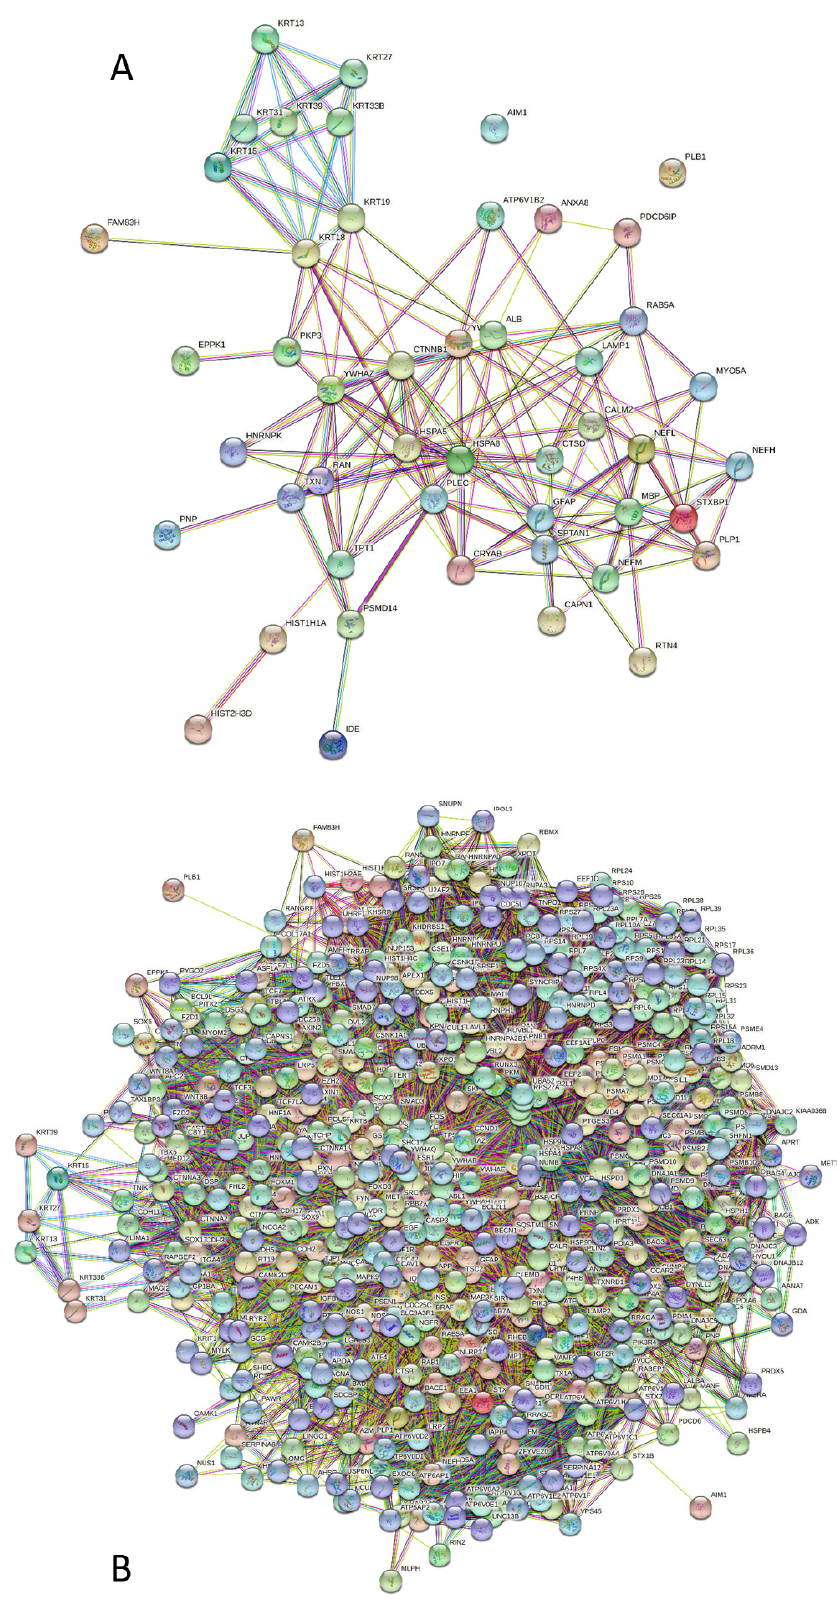
Figure 9. STRING-generated PPI network between NFs, GFAP, MBP and their 44 interactors found in the Heslington brain sample using APID ( A ), and a network that also includes a 1st shell of interactors of these proteins ( B